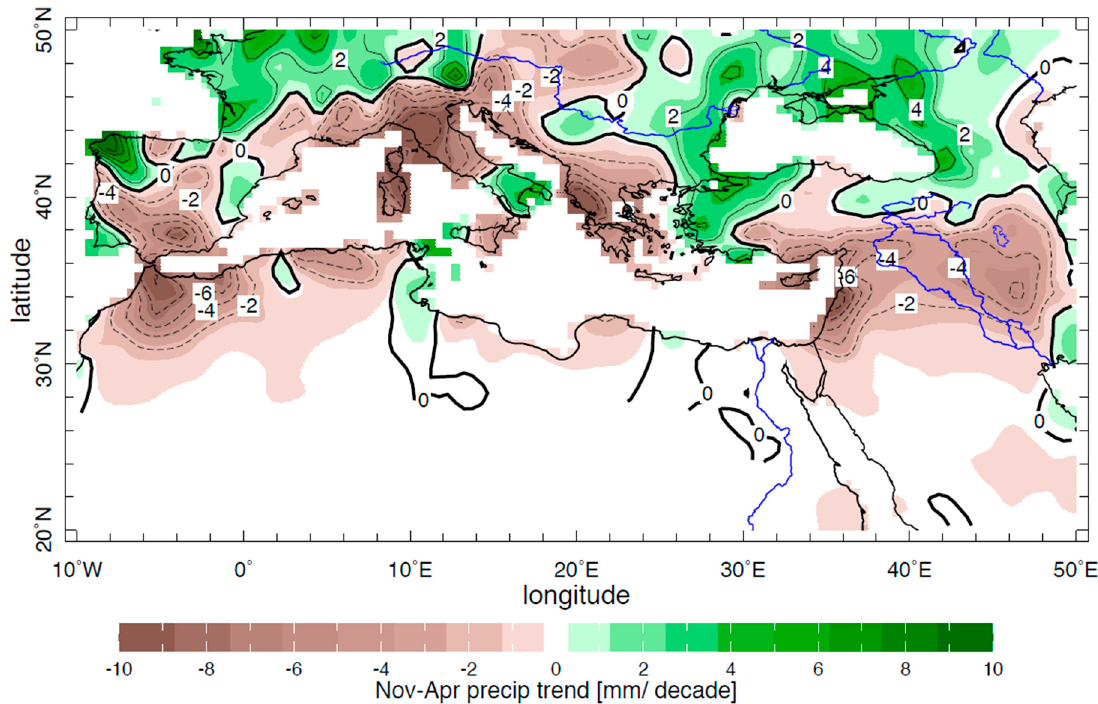
Figure 3. The trend in cold-season precipitation due to GHG forcing during the 20th century (colors and contours in mm decade − 1 ). Calculated by projecting the annual, cold-season (November–April) precipitation between 1902 and 2009 on the time series of annual GHG radiative forcing during the same period. Precipitation is from the University of East Anglia, Climate Research Unit TS3.1 gridded data. Greenhous gas annual forcing time series is from the Goddard Institute of Space Studies, “Forcings in GISS Climate Model, Well-Mixed Greenhouse Gases Historical Data” web page (https://data.giss.nasa.gov/modelforce/ghgases/). For more information on the method used to calculate the trend see [15] .